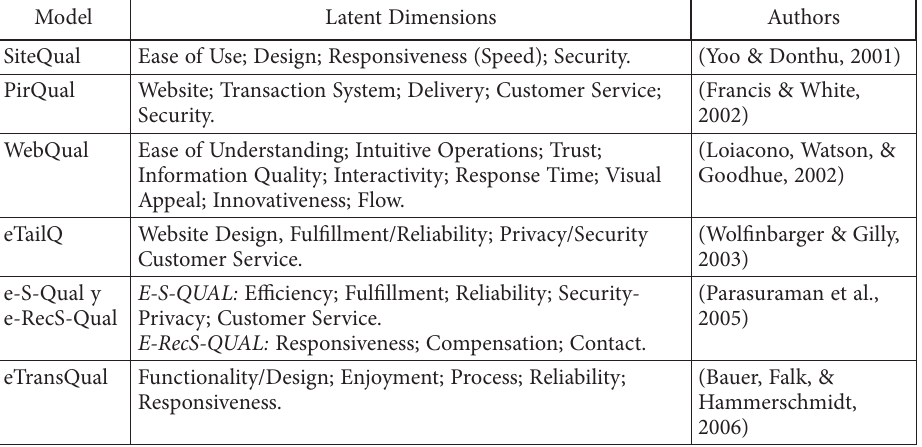
Table 1. A short review of main models proposed to measure e-service quality Model Latent Dimensions